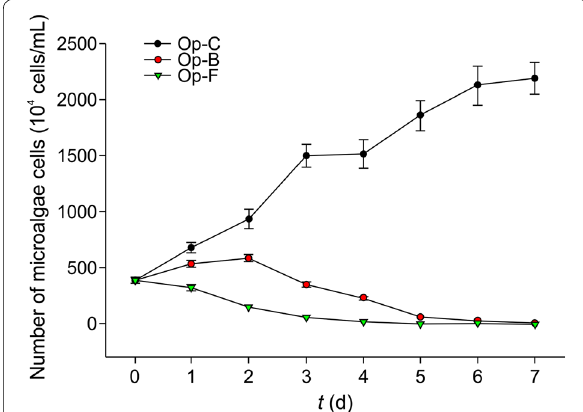
Fig. 5 Effects of CZBC1 on Oscillatoria planctonica growth. Op‑C: O. planctonica control group; Op‑B: O. planctonica + suspension group; Op‑F: O. planctonica